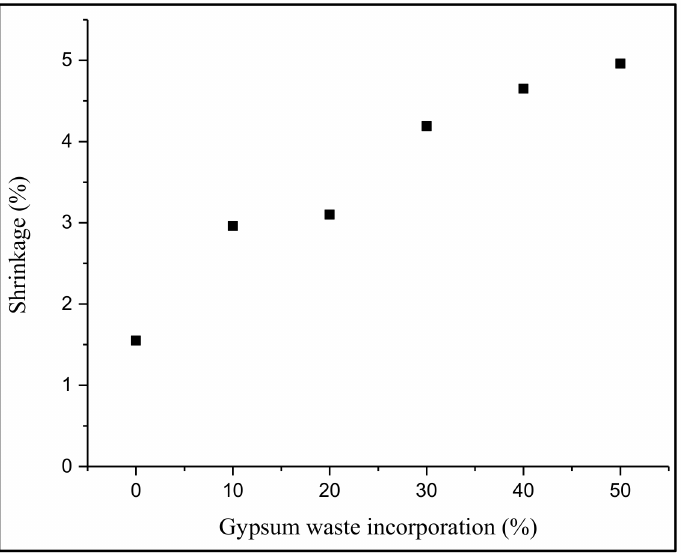
Figure 2. Effect of gypsum waste utilization on the shrinkage of fired clay